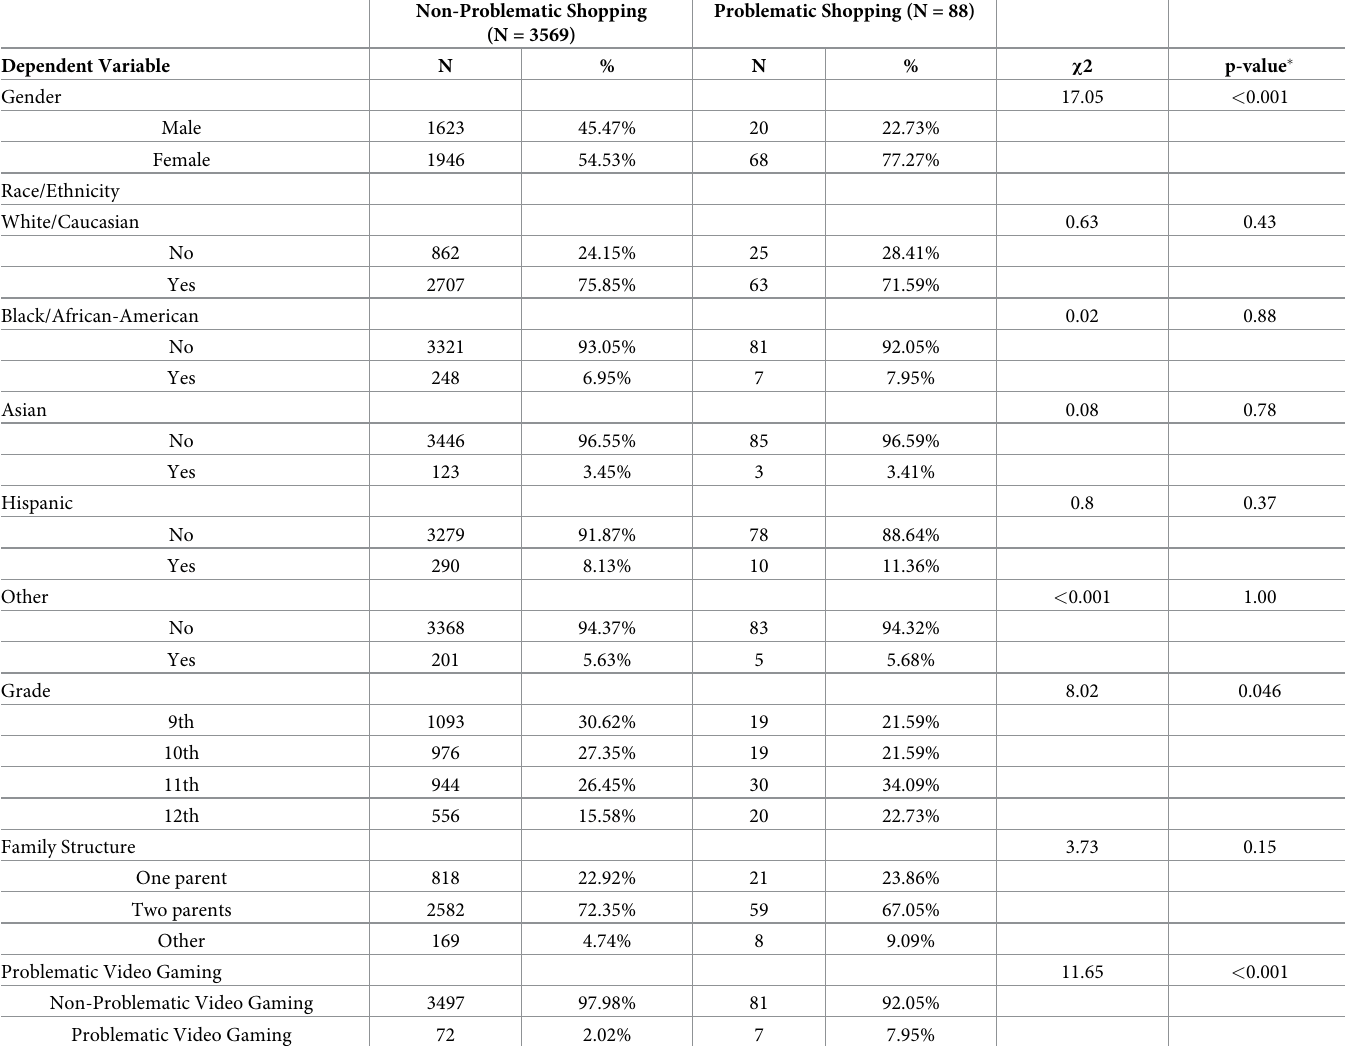
Table 1. Sociodemographic characteristics of adolescents with and without problematic